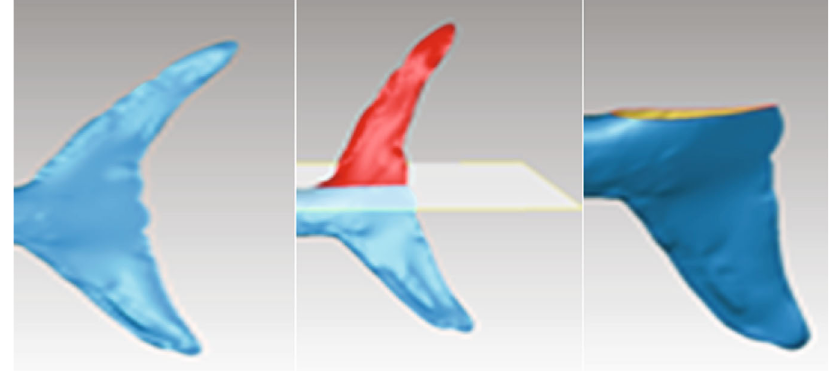
Figure 1: Data model of caudal fi n.